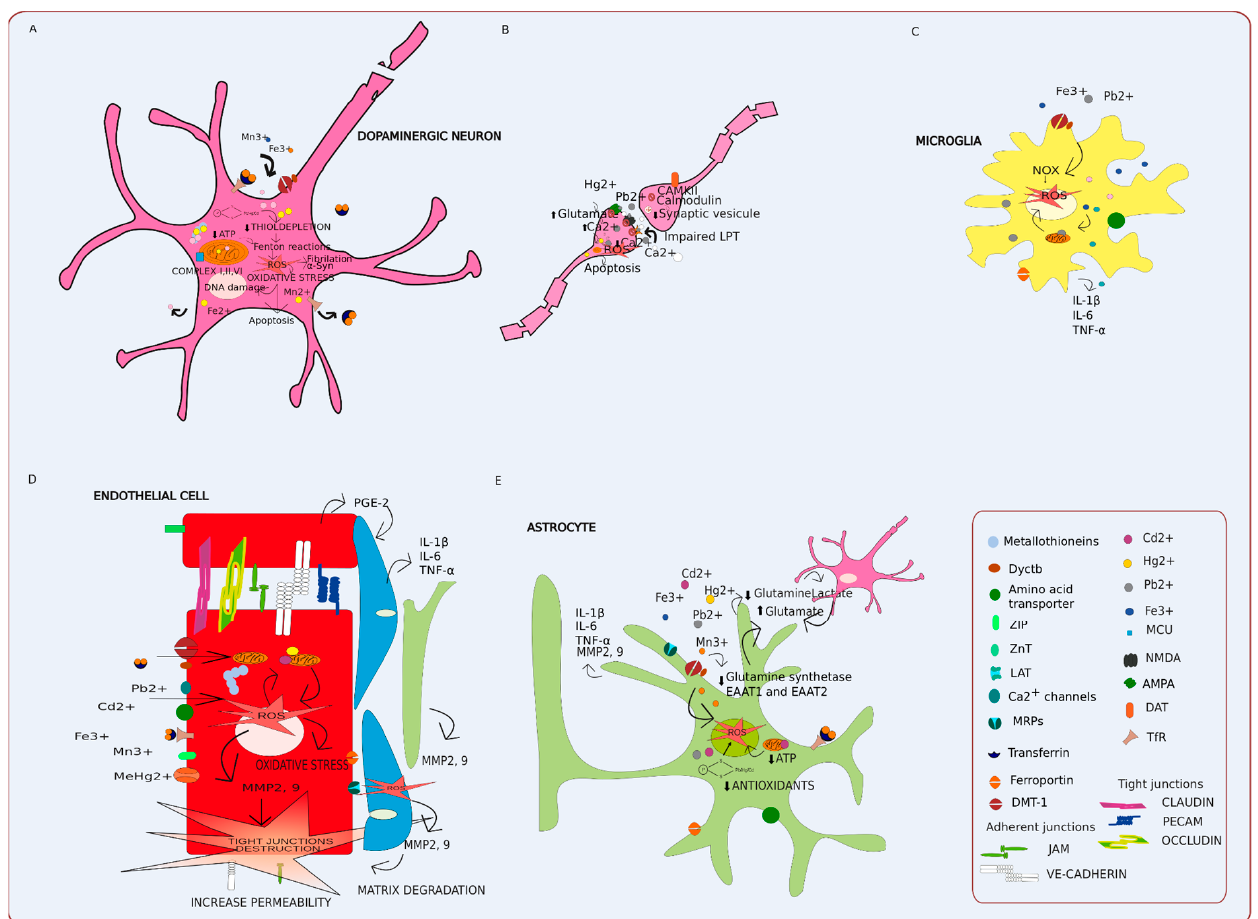
Figure 5. Heavy metals and oxidative stress in neuronal cells: the disruption of BBB through metal neurotoxicity and molecular mimicry. ( A ) Mn, Fe and other toxic metals accumulate within the mitochondria by utilizing the MCU. An increase in oxidative stress insults leads to a dysfunction of the mitochondrial electron transport chain. Metals that are able to bind to ADP via ATP-synthase uniquely uncouples oxidative phosphorylation and ATP formation within the mitochondria. Pb2 has an inhibitory effect on the activity of calmodulin and, consequently, leads to the avoidance of synaptic vesicles release [311–314,319–322]. ( B ) In the neuronal synapses, PB, Cd, and Mn impair Ca2+ channels (voltage-gated Ca2+ and Ca2+ ATPase) leading to Ca2+ ion avoidance and alterations in ion signaling. Pb2 has an inhibitory effect on the activity of calmodulin and consequently leads to the avoidance of synaptic vesicle release [323,324]. In the binding sites of postsynaptic cells at the NMDA-receptor/channel, and AMPA disturbances of the postsynaptic potential, leads to the synaptic plasticity and induction of LTP[323–325]. ( C ) Glial cells further increase the production of ROS by mitochondrial damage. Specifically, alterations in antioxidant levels and metal reactions further promote the activation of the NF-kB pathway by the release of proinflammatory cytokines (TNF- α , IL-1, IL-6). Increased cellular damage associated with the accumulation of metals promotes α -synuclein formation in astrocytes leads to the suppression of protective functions and a decrease in glutamate uptake, leading to excitotoxicity in neurons [326–333]. ( D ) In endothelial cells, the increase in ROS production promotes the release of metalloproteinase-9 and PGE-2 by endothelial cells. This factor then stimulates both pericytes and glial cells to further promote pro-inflammatory signals and, as a consequence, degrades the extracellular matrix of both tight junctions and BBB permeability [41,273,283]. (E) The interaction of glial cells with ROS leads to mitochondrial damage and the release of proinflammatory cytokines, which are further bolstered by the additional burden of heavy metals. This impairs the essential roles of neuron maintenance by disrupting glutamate/GABA-glutamine shuttling. The expression of EAAT1 and EAAT2 and the activity of glutamine synthetase can be downregulated by the excess of intra-astroglial heavy metals [334–337]. neuronal damage, finally leading to neurodegeneration[334,338,339]. Abbreviations: AMPA: α - amino-3-hydroxy-5-methyl-4-isoxazolepropionic acid, DMT1: Divalent metal transporter 1, DAT: dopamine active transporter, EAAT: excitatory amino acid transporter, IL-1: Interleukin-1, IL-6: In- terleukin-6, IL-12: Interleukin-12, JAM: junctional adhesion molecule, LTP: Long term potentiation,